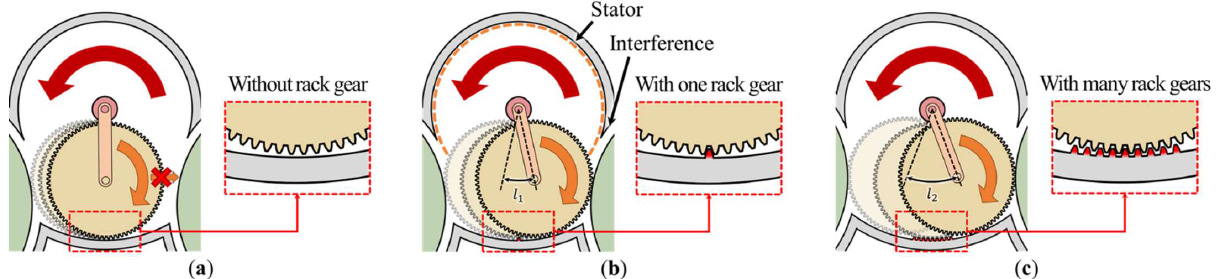
Figure 5. Rack gear design to minimize the distance of the moving gear: ( a ) without the rack gear, the moving gear rotates without moving to the pulley on the other side; ( b ) with one rack gear, the moving gear moves to the other pulley by distance l 1 ; ( c ) with many rack gears, the moving gear moves to the other pulley by distance l 2 (larger than l 1